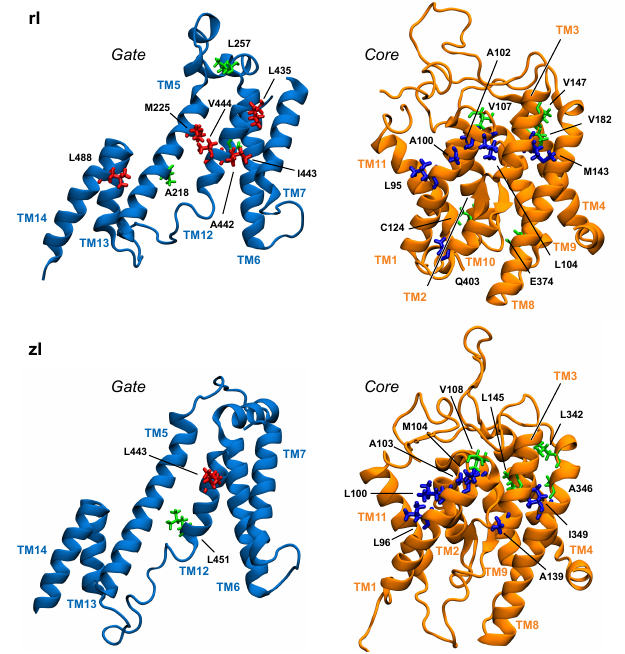
Figure 6. Position in the gate and core domains of the network hubs (in licorice) in the inward-open simulations, as viewed from the interdomain interface. Residues on gate and core that are located at the interface are colored red and blue, respectively. Hub residues not located at the interface are colored green.